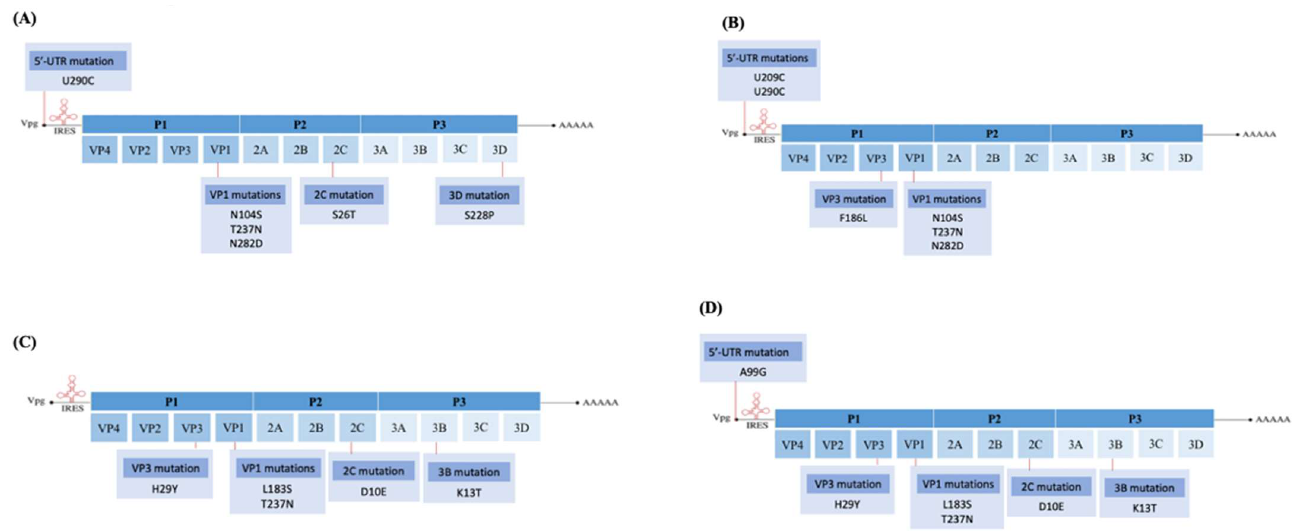
Figure 3. Differences in amino acid sequences between the ( A ) EV-A71/SP small plaque variant, ( B ) EV-A71/MP medium plaque variant, ( C ) EV-A71/BP big plaque variant and ( D ) EV-A71/HP huge plaque variant isolated from RD cells in comparison with the EV-A71/WT. VP indicates viral pro- tein. Table 3. Similarity nucleotide sequences of plaque variants EV-A71/SP, EV-A71/MP, EV-A71/BP and EV-A71/HP with all the six haplotypes.